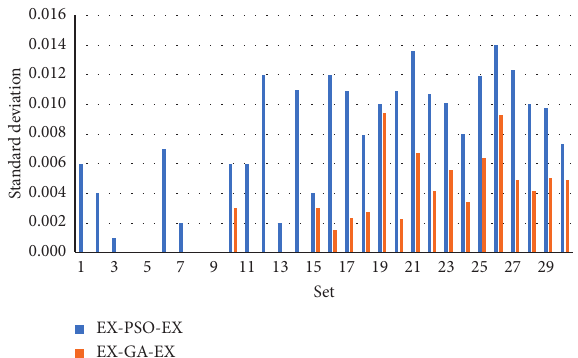
Figure 8: Comparison of standard deviation of the value of the objective function in EX-PSO-EX and EX-GA-EX (sets